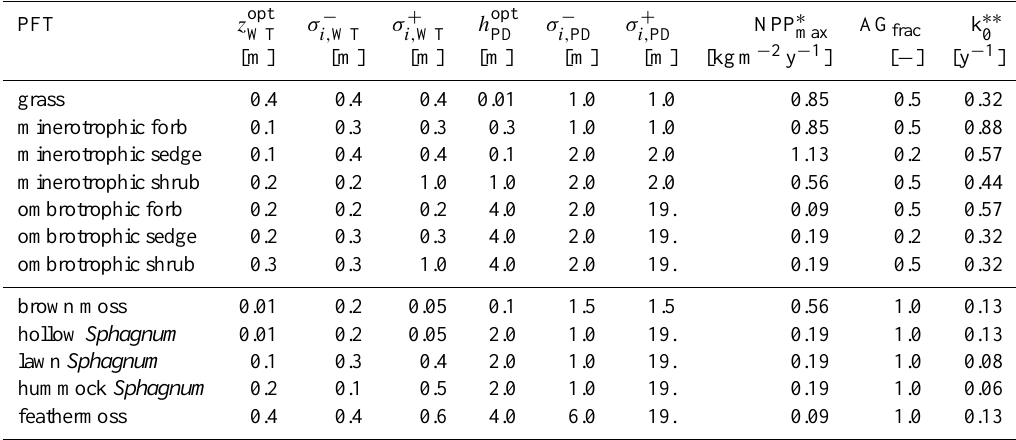
Table 1. Characteristics of plant functional types (PFTs), including productivity optimum water table depth ( z opt Variance (width) of the Gaussian curve representing productivity (Eq. 6; Fig. 6) can differ for water table depth and/or peat depth values less (shallower) than optimum ( σ − and σ − ) and greater (deeper) than optimum ( σ + i, WT i, PD PFT at its optimum water table depth and peat depth, AG frac is the aboveground fraction of total NPP, and k 0 is initial litter decomposition rate. See text for